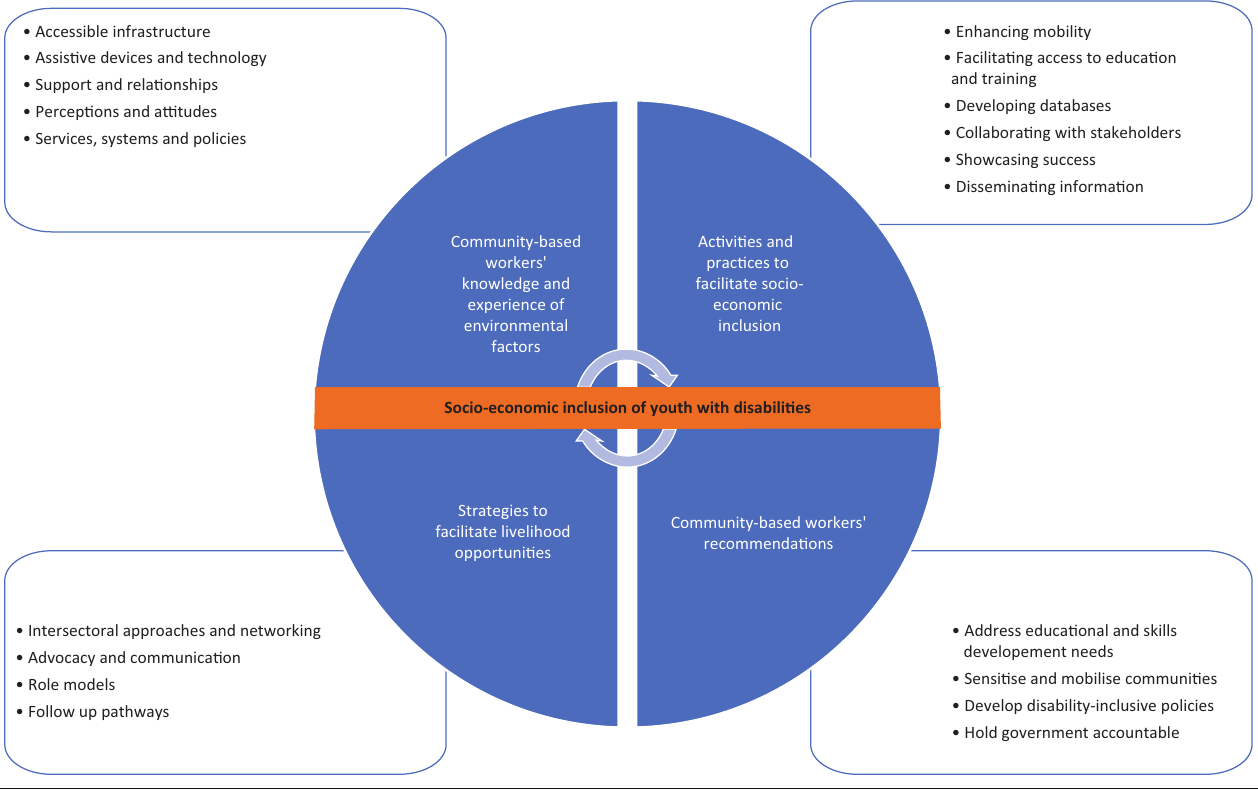
FIGURE 1: Key findings categorised in